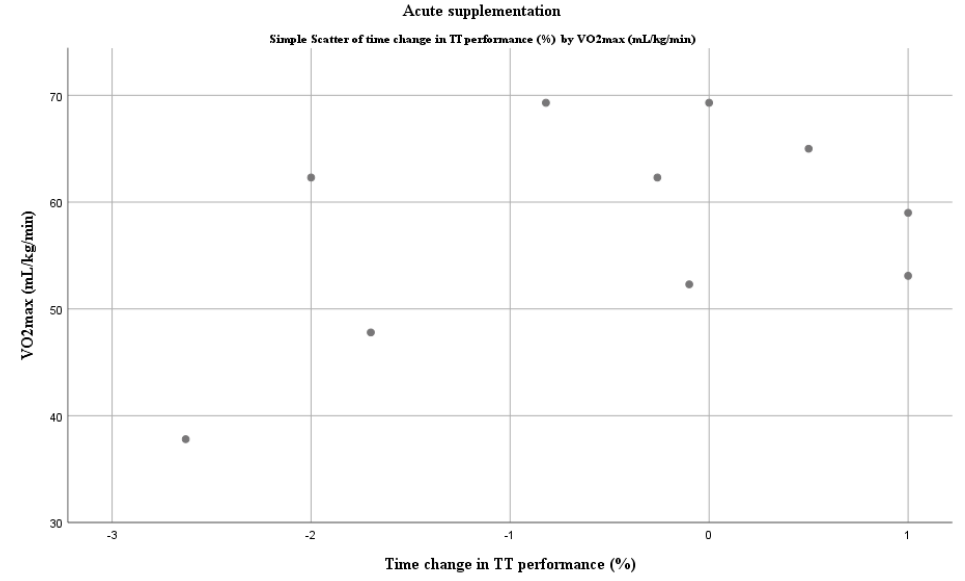
Figure 4. Relationship between VO 2max and DN ergogenicity in TT tests: acute supplementation protocol. Negative values in time change represent improvement as the task was finished in less time.